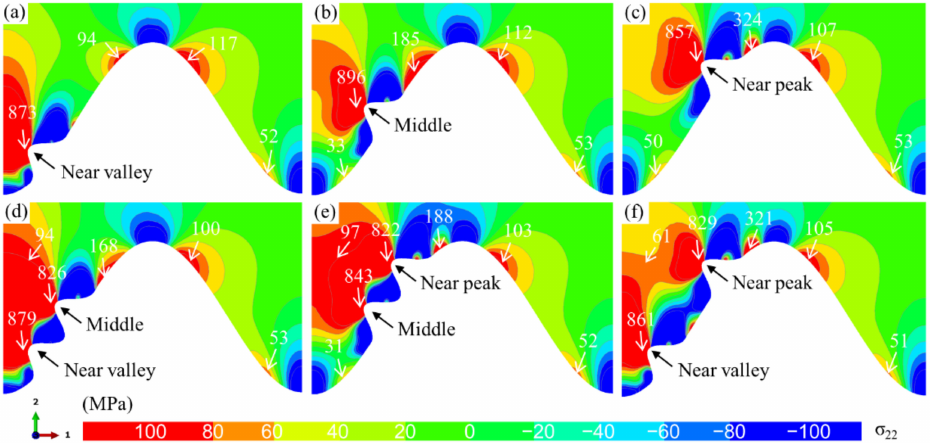
Figure 8. Effects of the location and number of bulges on the σ 22 normal stress distribution ( N = 20, at room temperature): ( a – c ) one bulge at the interface and ( d – f ) two bulges at the